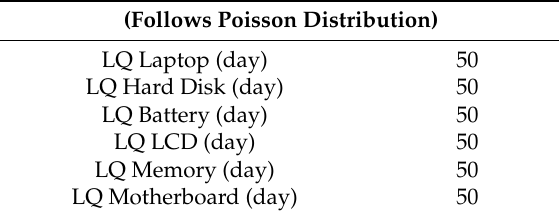
Table A2. Low-quality remanufactured laptop, subassembly, and component demands.